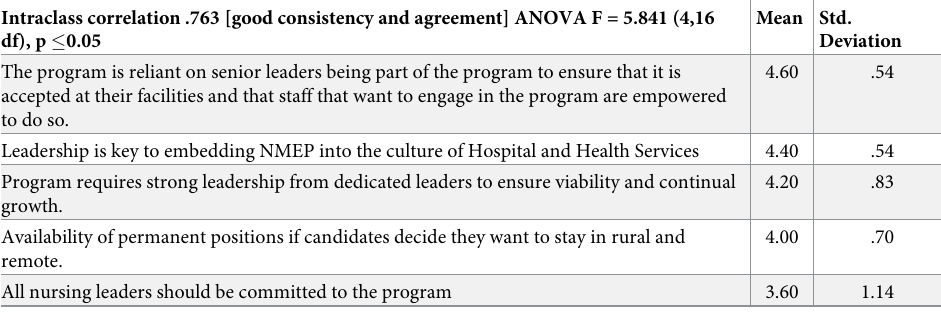
Table 10. Rate how you regard the following components in regard to LEADERSHIP influencing the success and sustainability of the NMEP program. Intraclass correlation .763 [good consistency and agreement] ANOVA F = 5.841 (4,16 df), p � 0.05